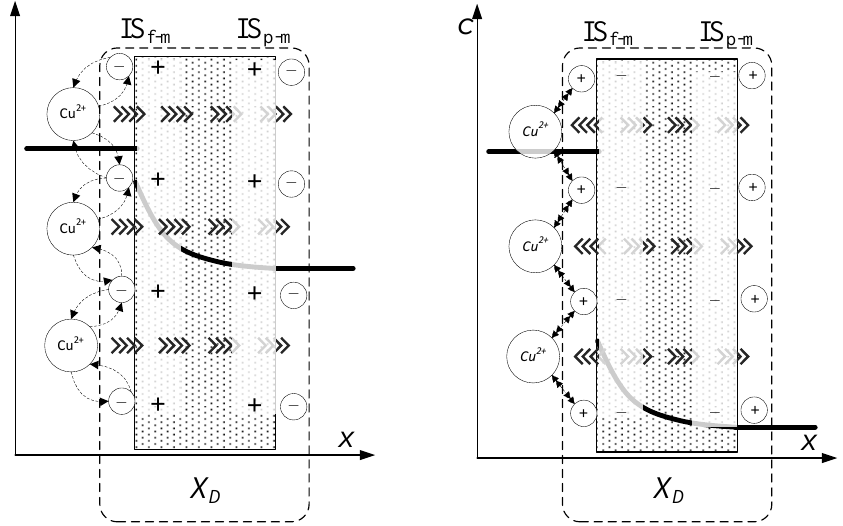
Figure 8. Schematic representation of amphoteric behavior of TiO 2 / Al 2 O 3 active layer of membrane during separation of aqueous solution of Cu(NO 3 ) 2 .